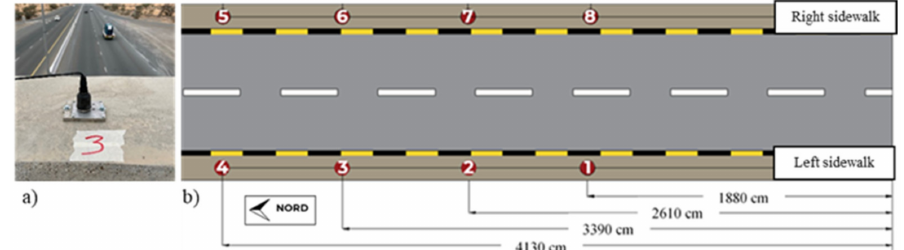
Figure 3. ( a ) PCB 393A03 accelerometer; ( b ) position of the accelerometers on the deck.